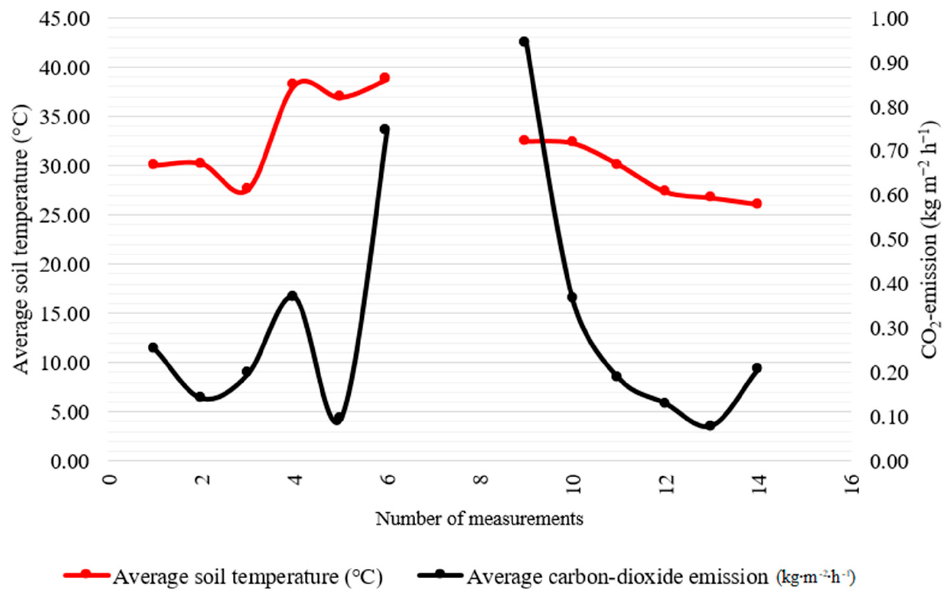
Figure 7. Soil temperature (°C) and carbon-dioxide-emission (kg m − 2 h − 1 ) results for the 2020 scheme.